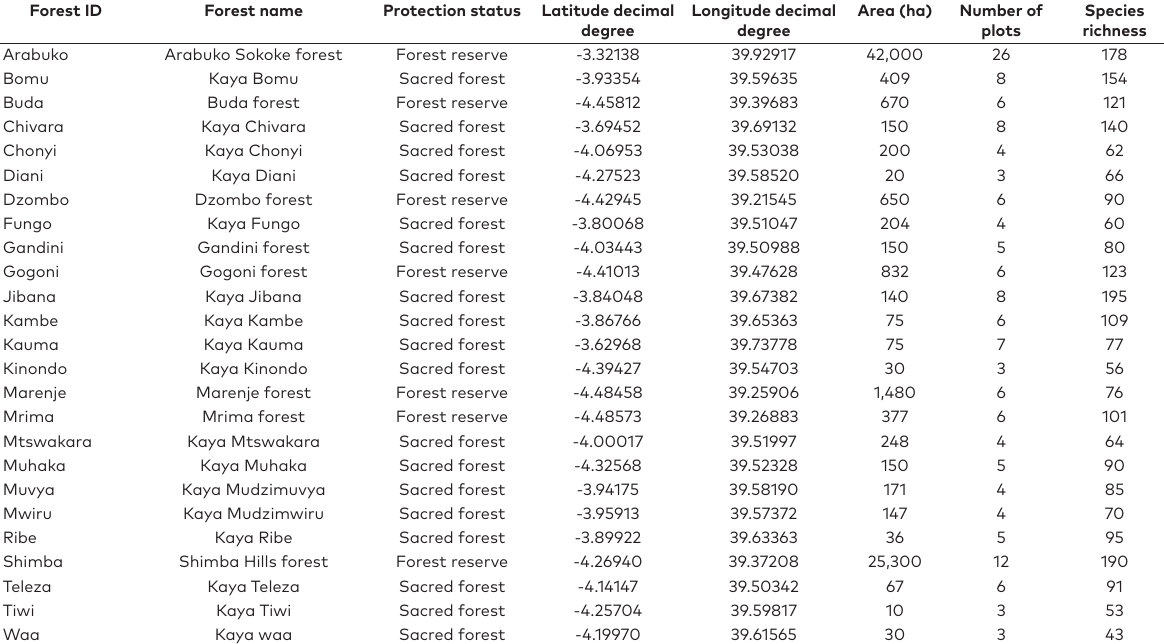
Table 1. Overview of the forest sites included in the Kenyan coastal forest vegetation-plot database, with an indication of their protection status, geographical coordinates, area, number of plots and recorded total species richness per forest site. Forest